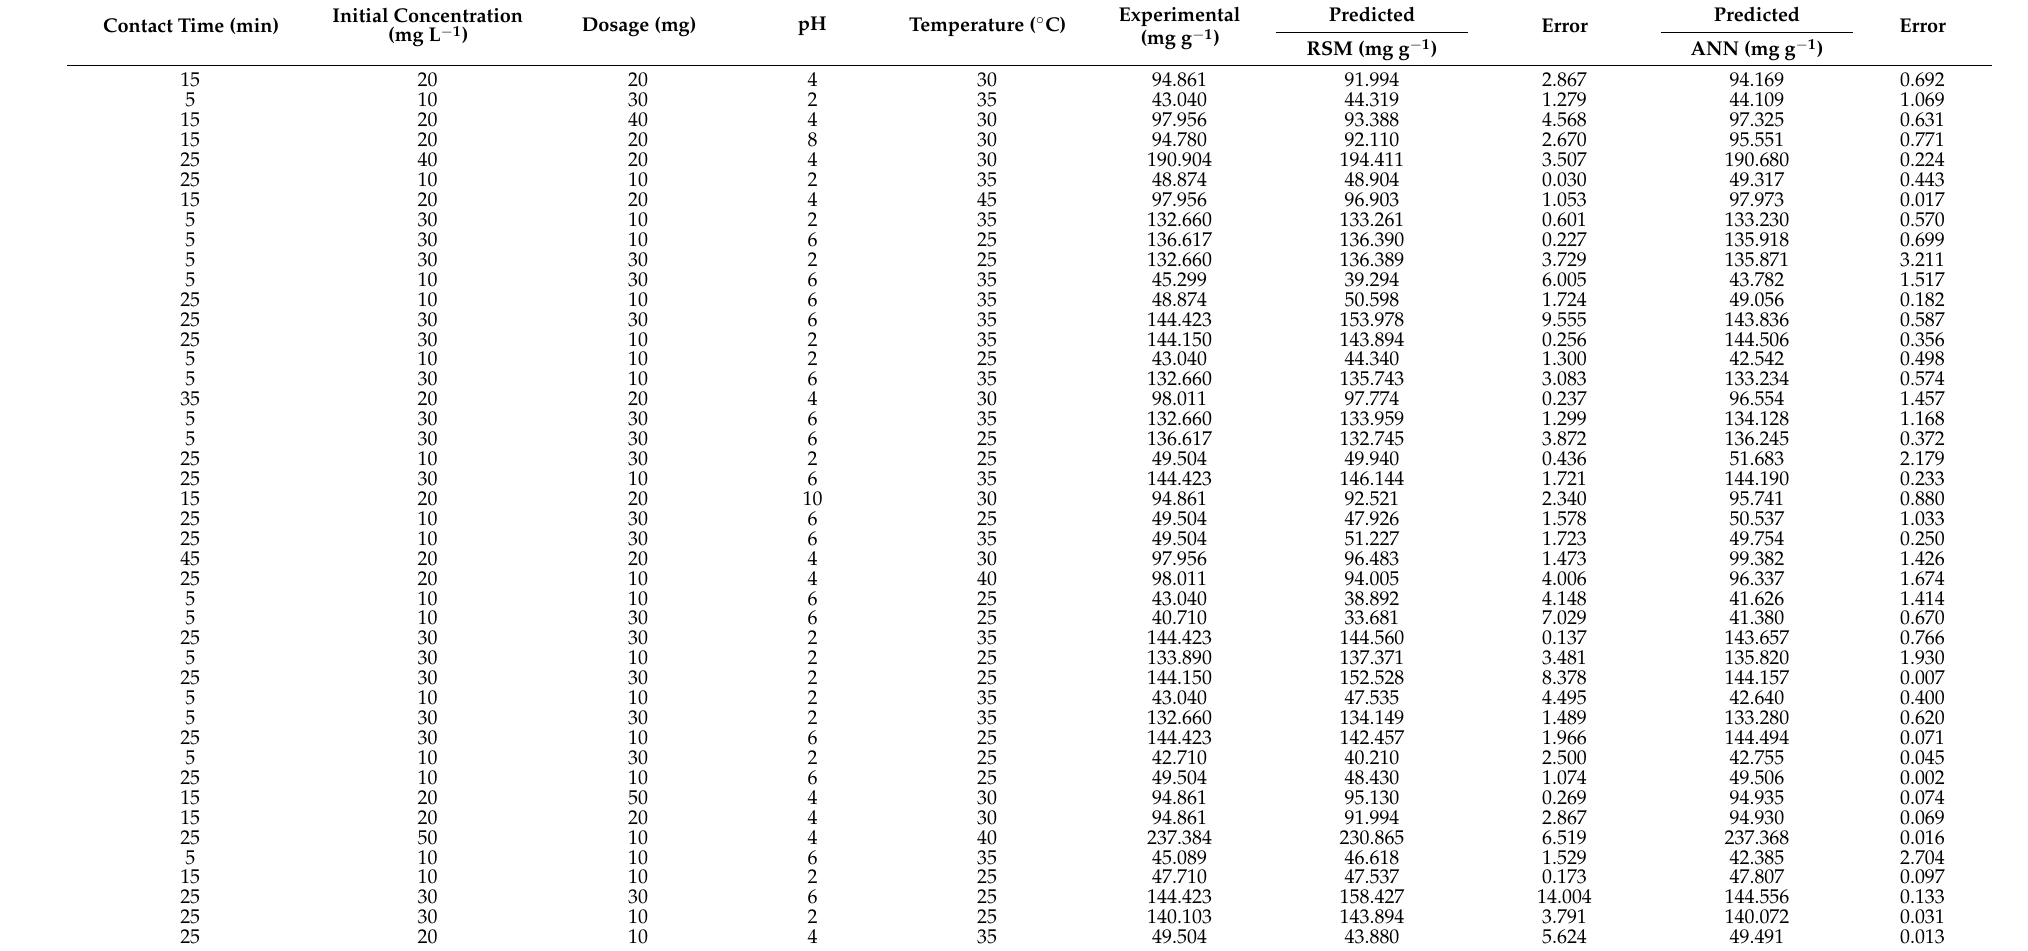
Table 6. Comparison between RSM and ANN model for predicting dicamba adsorption